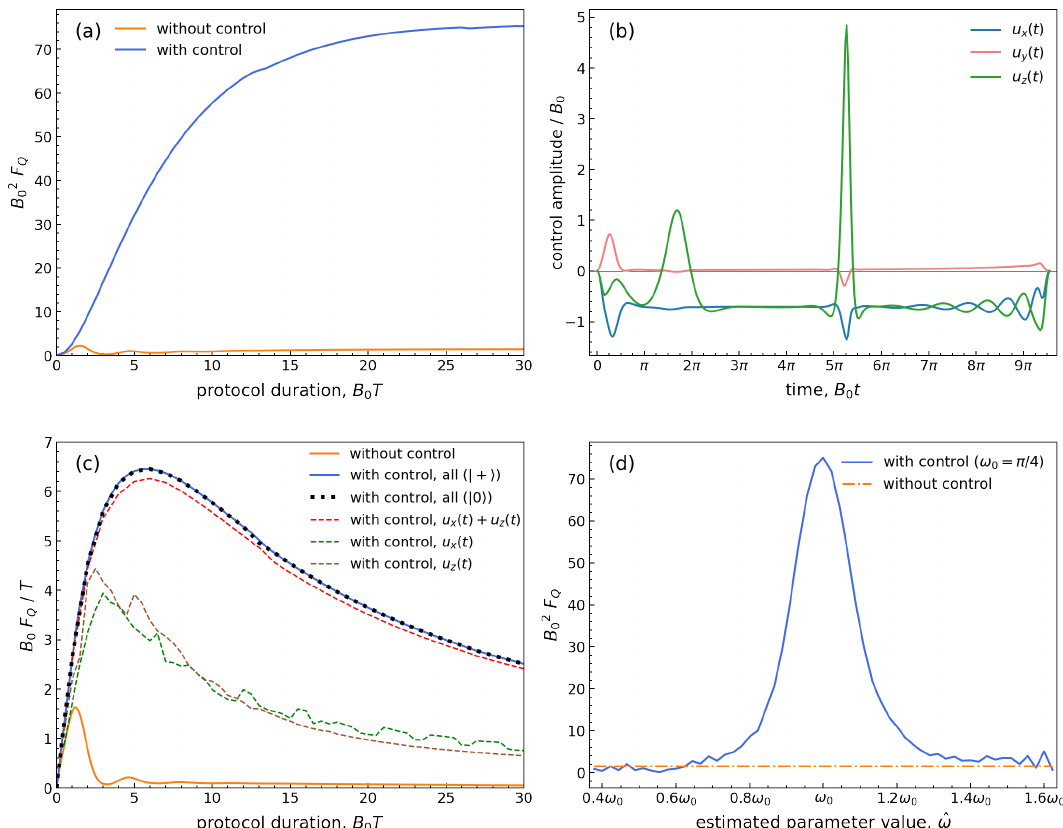
Figure 6: Non-commuting dynamics with parallel dephasing γ = 0.1 and relaxation − 2 ) achieved without control, γ = 0.2, ω = π/ 4 radian (a) The QFI (in units of B − 0 0 − 1 ). (b) Optimal and with control optimised at different duration T (in units of B 0 controls obtained using Krotov’s method for the dynamics with T = 30. (c) Nor- malised QFI (by T ) without control (orange line), with control in all directions (blue ( t ) (green dashed line) or u ( t ) (brown dashed line), and line), restricted to only u x z ( t ) and u ( t ) (red dashed line). (d) The QFI achieved using a combination of both u x z by applying controls optimised with different estimated parameter values ˆ ω on states evolved under the true parameter value ω 0